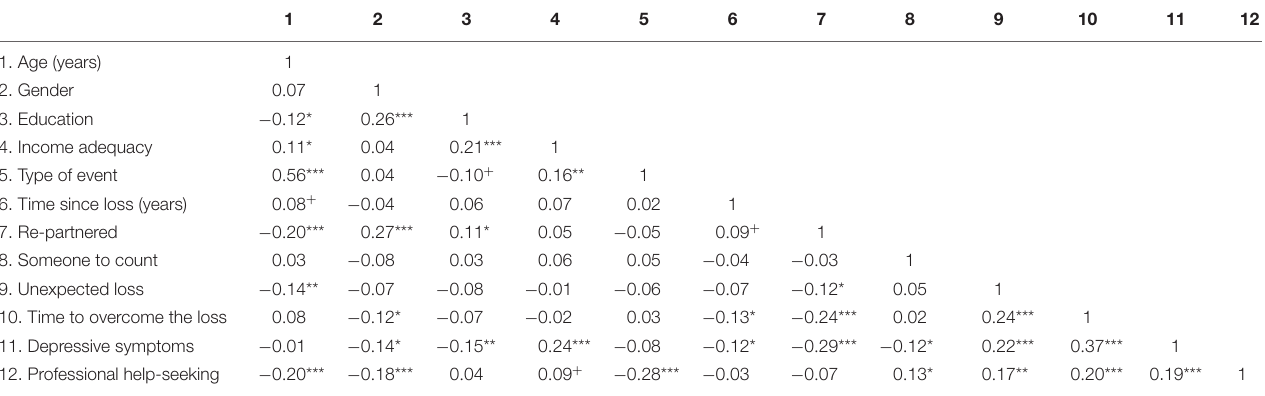
TABLE 2 | Correlations between the person and event-related characteristics and PHS of the total sample ( N = 388). 1